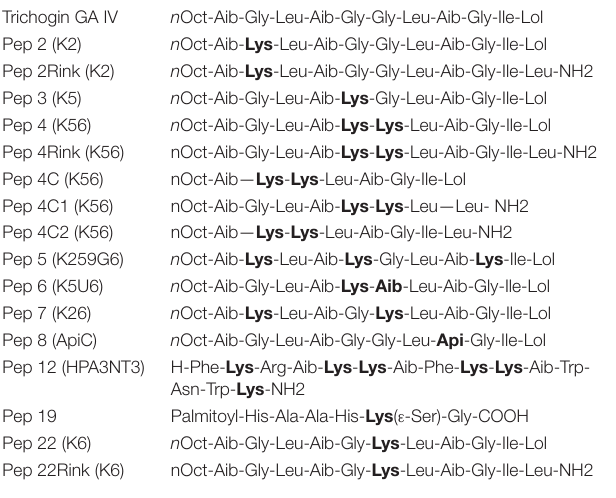
TABLE 1 | List of peptide analogs used in this work and their amino acidic sequence. Trichogin GA